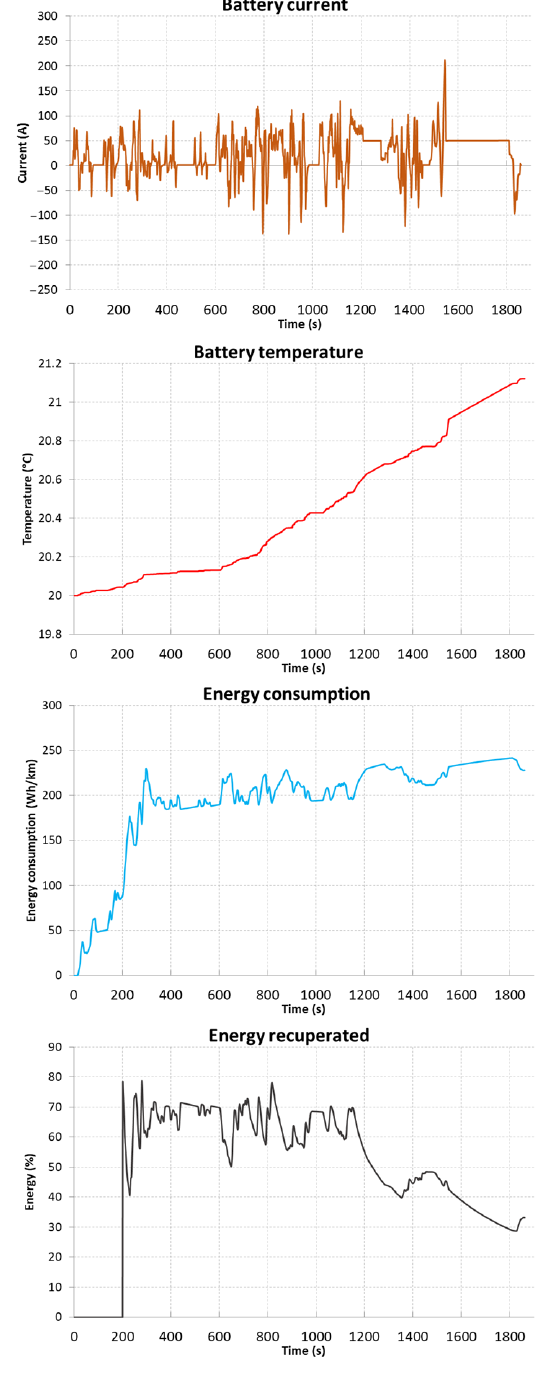
Figure 18. WLTP-90 results of simulation tests for the 4 × 4 drive system with Type 3 energy storage.